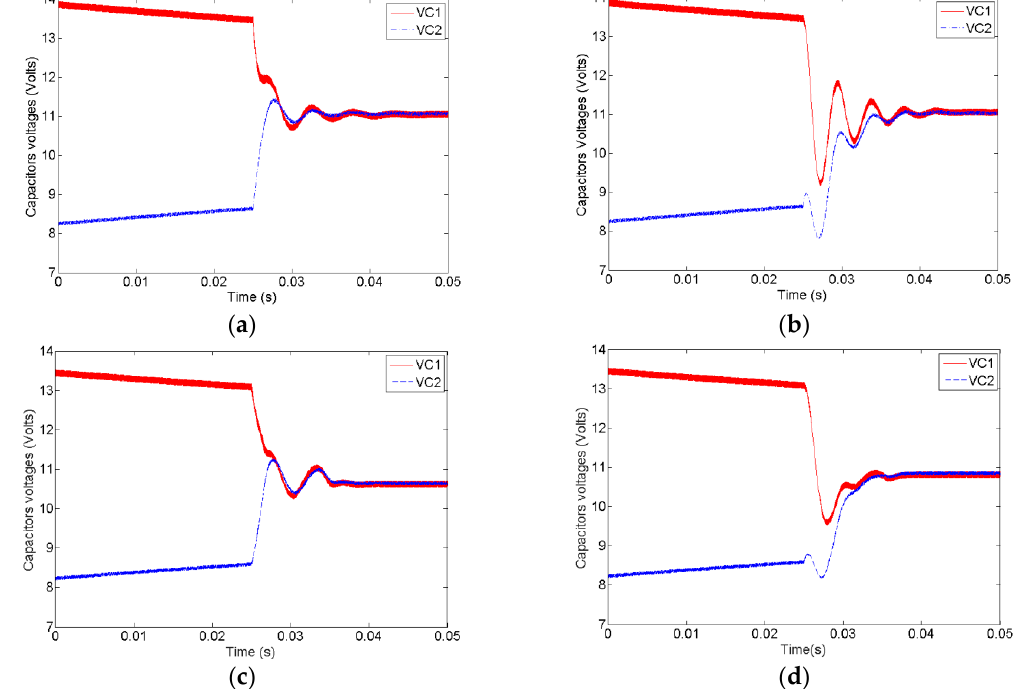
Figure 11. Simulated output capacitors ′ voltage curves after applying a balancing control at t = 0.025 s: ( a ) on both switches using a PI VB controller, and ( b ) on the lower switch using a PI VB controller, ( c ) on both switches using a Fuzzy VB controller, and ( d ) on the lower switch using a Fuzzy VB controller.